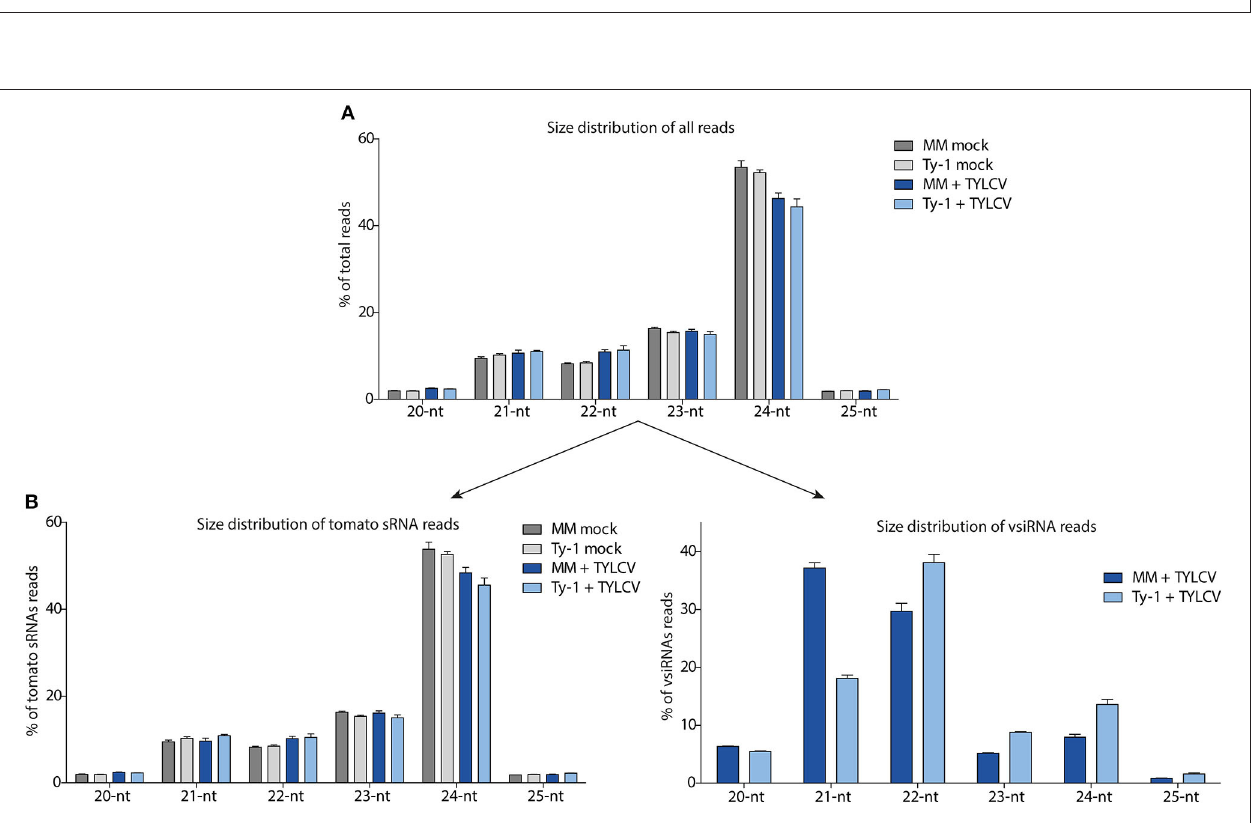
FIGURE 3 | Size distribution of the total sRNAs, sRNAs mapping to the tomato genome, and siRNAs mapping to the viral genome (vsiRNAs). The sRNAs reads of the four groups (MM and Ty-1 tomato, mocked treated, and TYLCV-infected) were analyzed on size. (A) The percentage for each size class (20–25 nt) on the total amount of reads is plotted. (B) The library of all reads was split into host-derived sRNAs and vsiRNAs and the percentage for each size class (20–25 nt) is depicted relative to the total amount of reads mapping to the tomato genome (left panel), and relative to the total amount of reads mapping to the viral genome (right panel). Viral reads are only analyzed from TYLCV infected plants (right